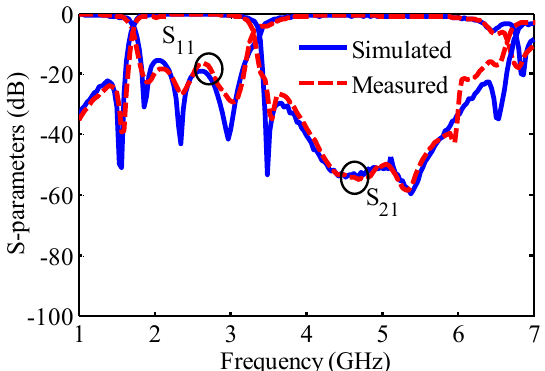
Figure 13. Simulated and measured S -parameter results of the proposed reconfigurable bandwidth BPF with λ g /2 short-ended stubs for the narrowband state along with fabricated prototype.